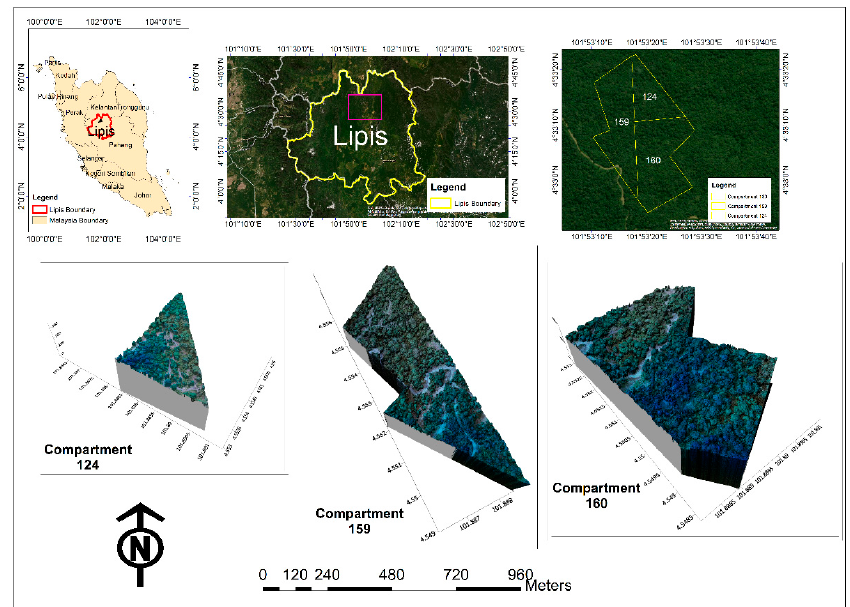
Figure 1. Map of study areas in Ulu Jelai Forest Reserve, Lipis, Pahang, Malaysia. The bottom panel shows the three compartments of logging license 124, 159 and 160.